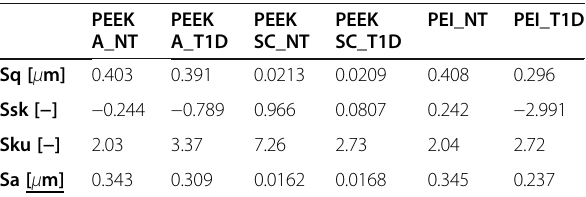
Table 3 3D roughness values as received and after plasma